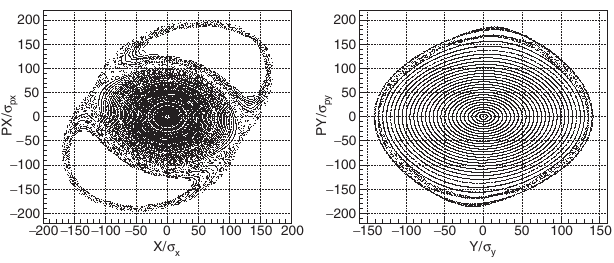
FIG. 6. Action and phase evolution for two particles with initial conditions: stable particle (red) with x 0 ¼ 66 σ and unstable x particle (blue) with x 0 ¼ 67 . 1 σ , the remaining five initial x coordinates are zero. Square root of action (left). Action beating due to synchrobetatron coupling is clearly visible. Phase advance FIG. 8. 4d tracking phase trajectories: horizontal initial con- (right). Particle becomes unstable when the phase advance crosses ditions only (left) and vertical initial conditions only (right). σ integer value.